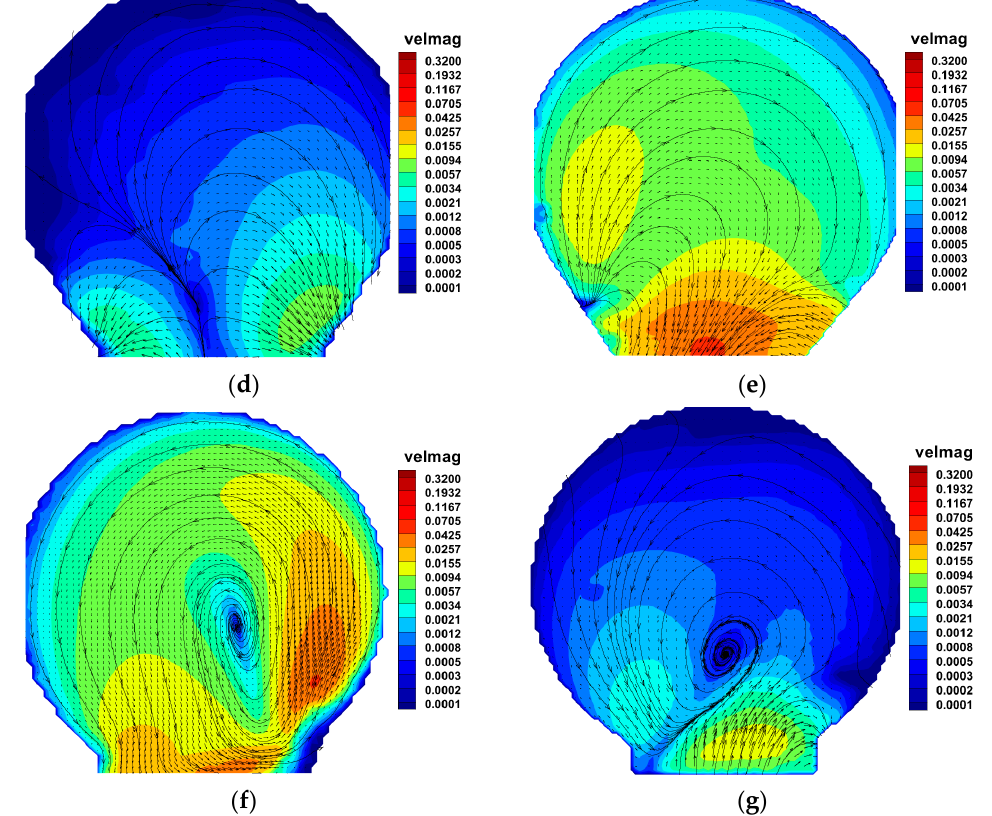
Figure 4. Velocity colour mapping and flow streamlines for different implants in sidewall and bifurcation geometry; note that logarithmic color mapping was used to enhance the comparison of contours. ( a ) Case 1, bifurcation, no implant, ( b ) Case 2, bifurcation, eBRS, ( c ) Case 3, bifurcation, eB, ( d ) Case 4, bifurcation, eBFD, ( e ) Case 5, bifurcation, PED, ( f ) Case 6, sidewall, no implant, ( g ) Case 7, sidewall, PED.